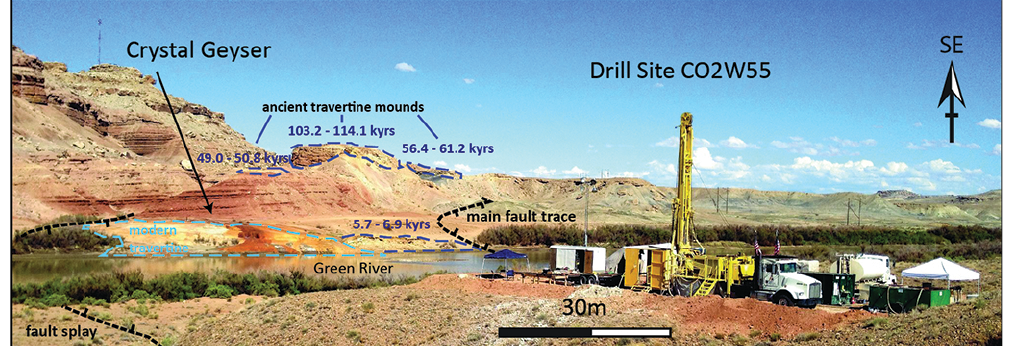
Figure 2. Field photograph of the drill site of well CO2W55 showing the CS4002 Truck Mounted Core Drill in the foreground and the travertine mound formed by Crystal Geyser on the opposite bank of the Green River. Also shown are the main fault trace of the Little Grand Wash Fault, and the local fault splays. Ancient travertine mounds form away from the main fault trace, within the footwall block of the fault, above the main fault damage zone through which CO 2 and CO 2 -charged brine escape to surface. Travertine mound ages from Burnside et al. (2013) are also